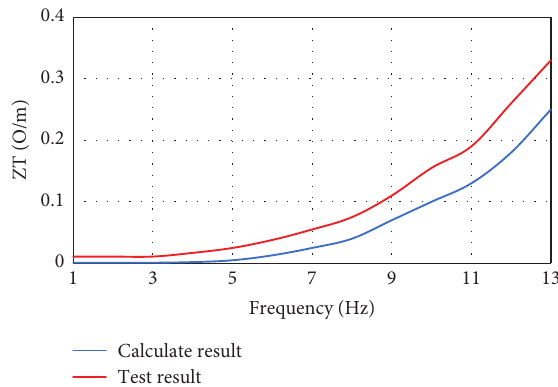
Figure 5: Transfer impedance of syv1 power cable.